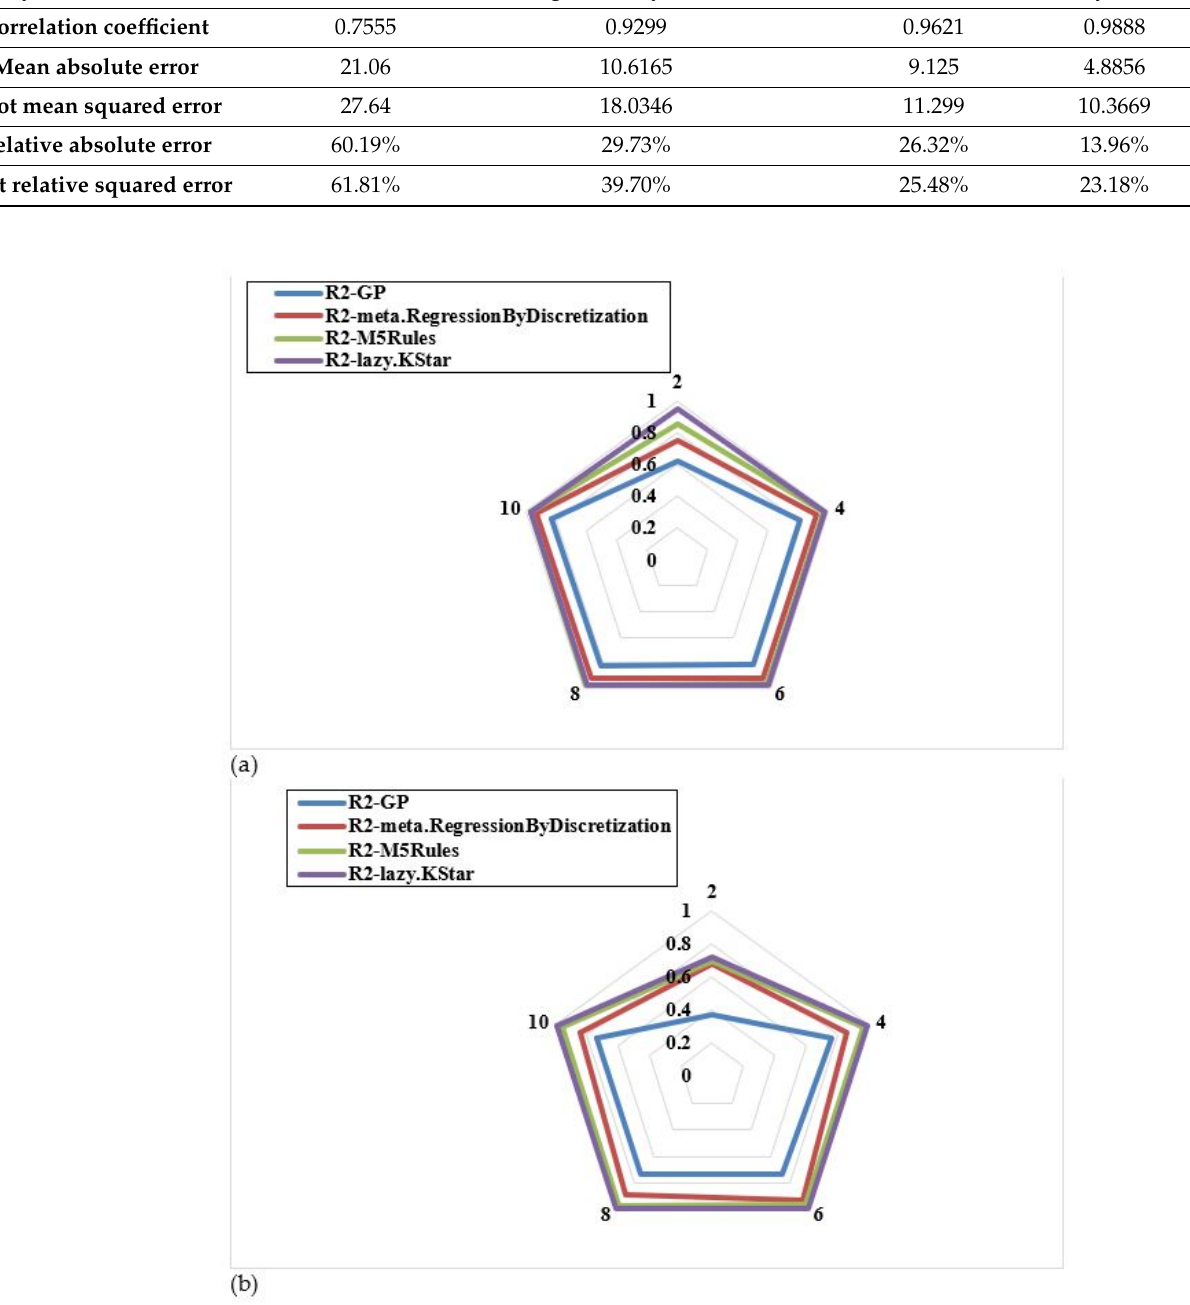
Figure 6. The R-squared fluctuations in different K-fold training numbers as per ( a ) response time and ( b ) sensitivity.